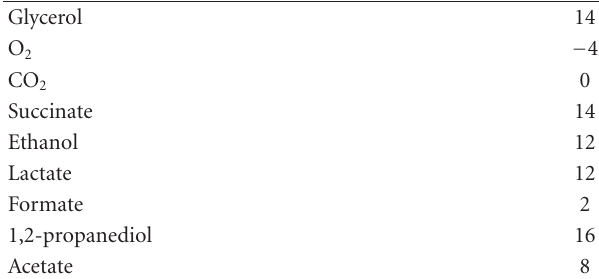
Table 2: Degree of reduction of considered substrates and